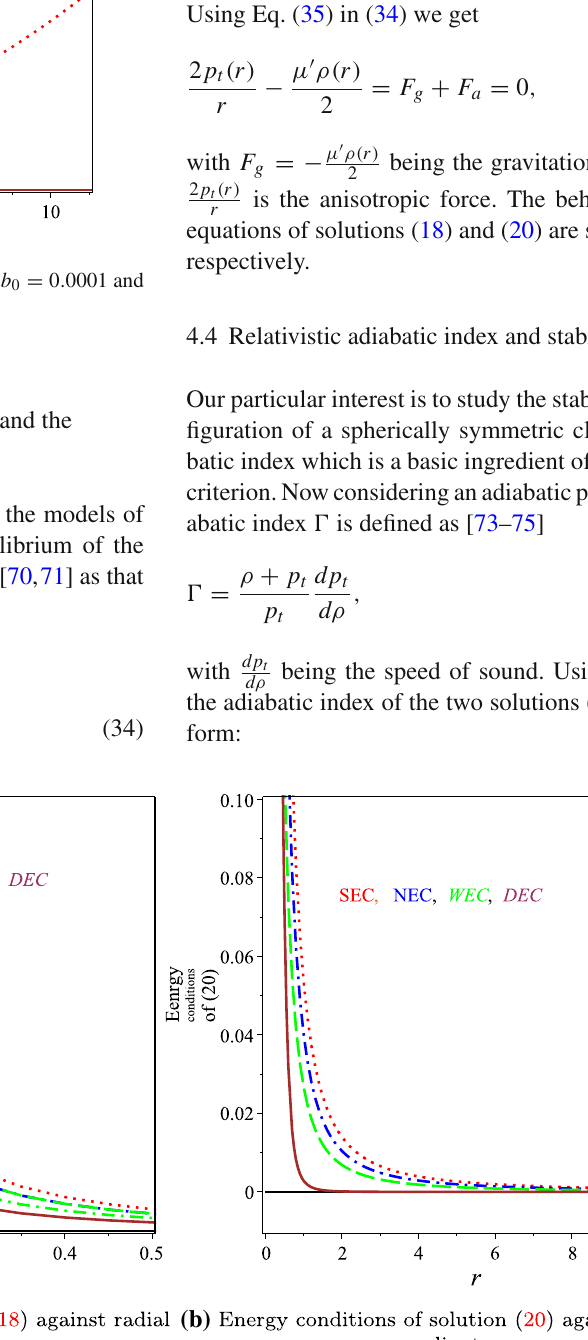
Fig. 6 The energy conditions of solutions (18) and (20) against r in km when b 0 = 0 . 0001 and b 1 = 0 .